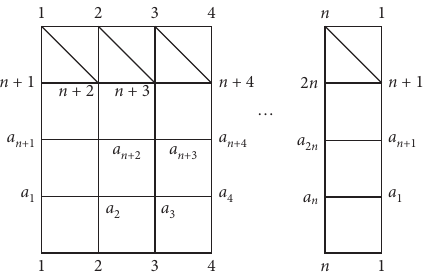
Figure 12: DSEM of type- [ 3 3 , 4 2 : 4 4 ]